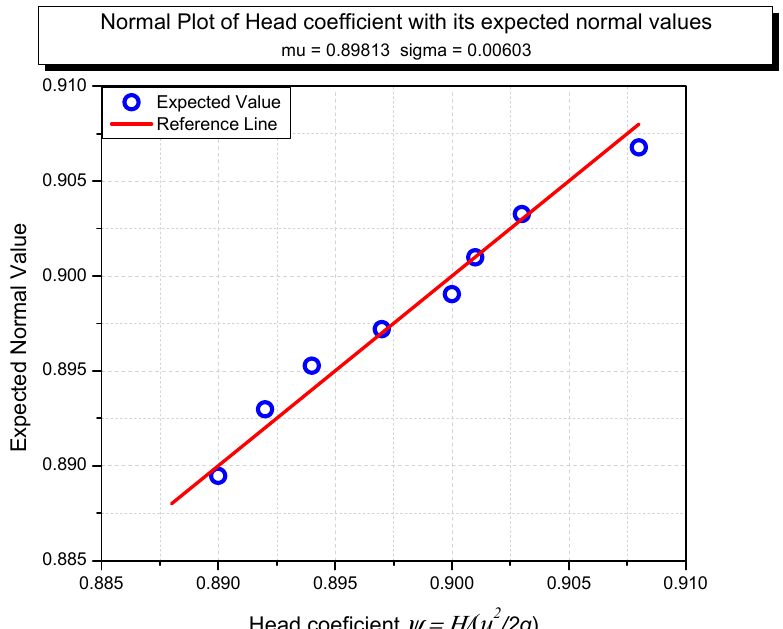
Figure 9. Head coefficient and its expected average values.